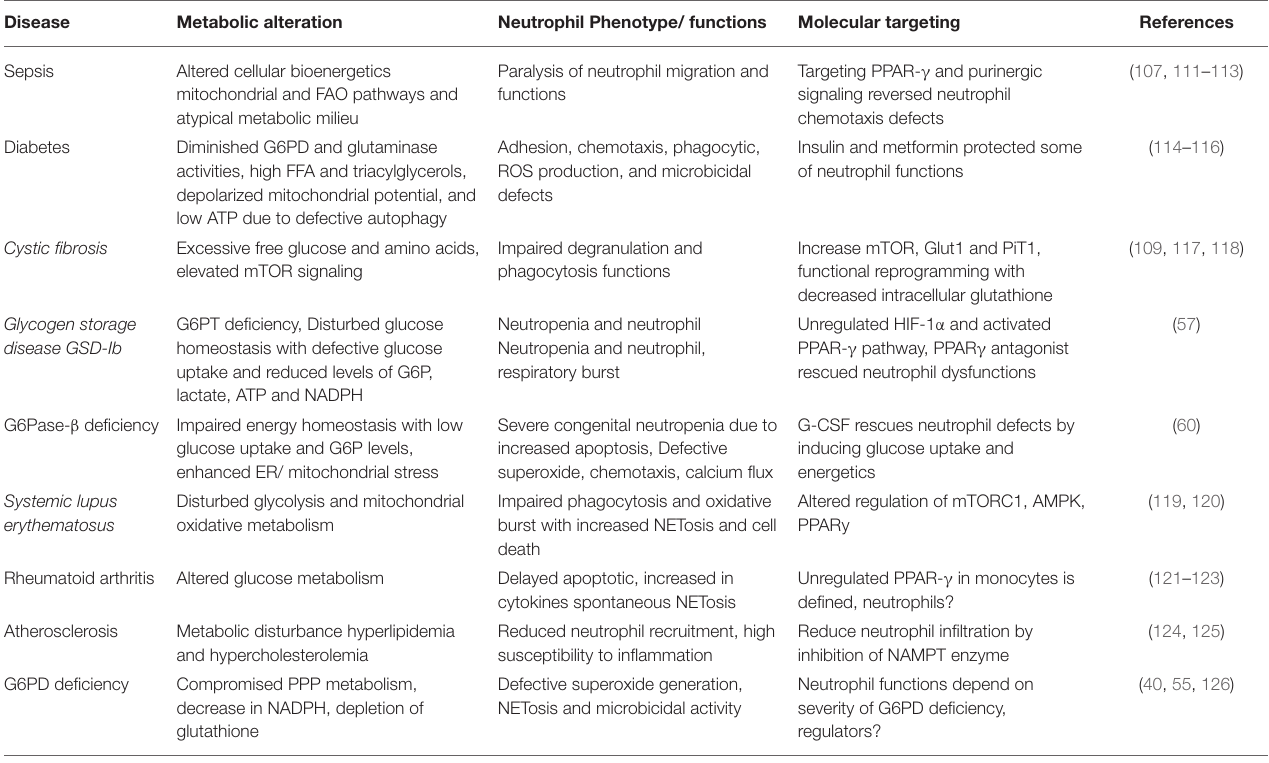
TABLE 3 | Metabolic alteration responsible for neutrophil dysfunctions in disease